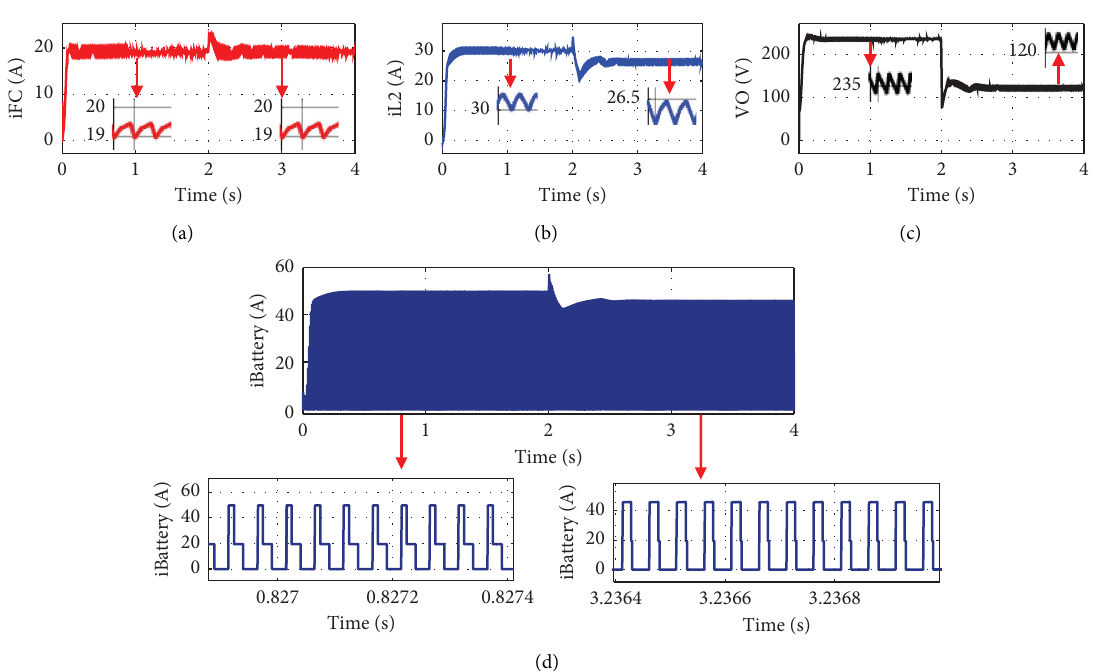
Figure 27: DC-DC converter specifcations in the third mode. (a) Current of FC. (b) Current of iL2. (c) Output voltage. (d) Current of the battery.